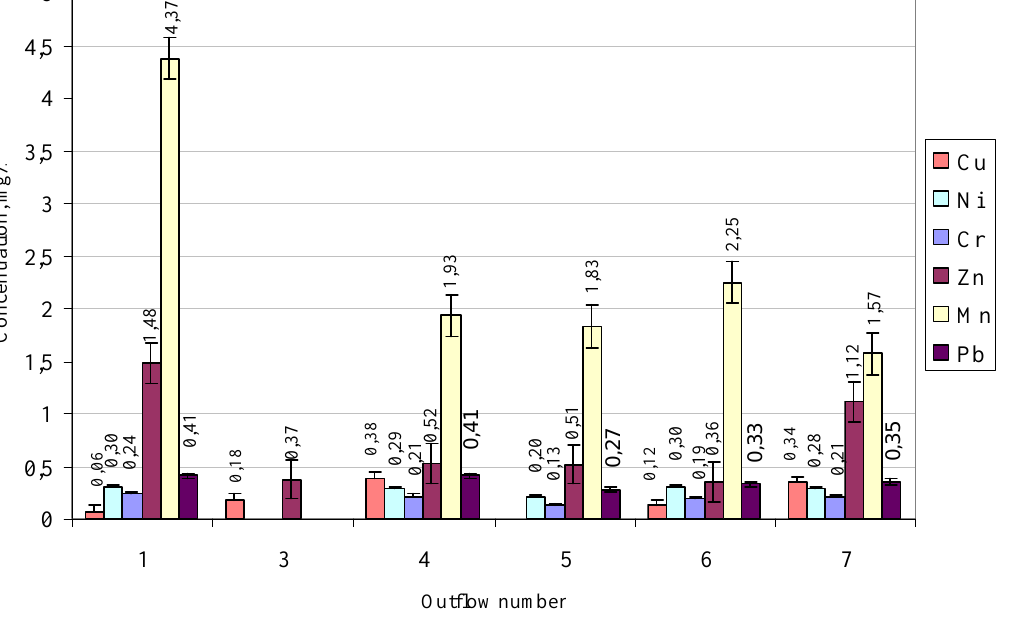
Fig. 3. Heavy metals concentration in outflow *Comment. There are gaps in outflow 3 of Ni, Cr, Mn, Pb and 5 of Cu, because results are above confidence